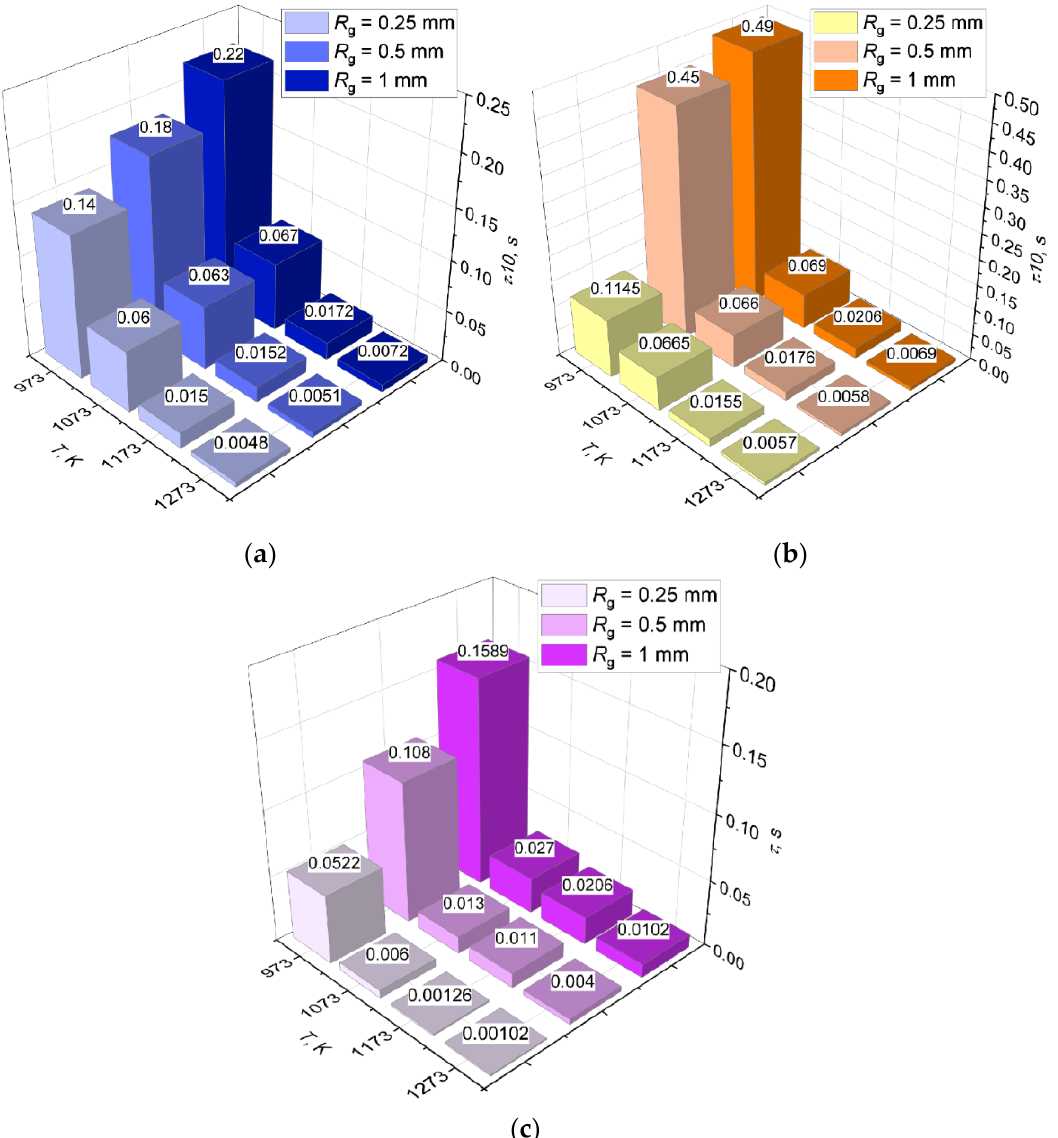
Figure 3. The gas hydrate ignition delay times when varying the gas hydrate particle radius and heating medium temperature for three heat exchange schemes: ( a ) radiant, ( b ) conductive, ( с ) convective.